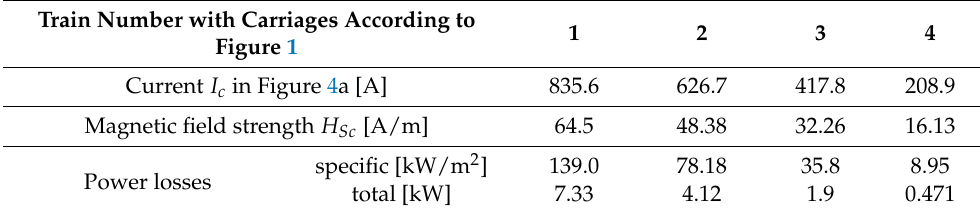
Figure 4. Calculation schematic for the superimposition and mirror image methods of the magnetic field on the roof of the electric locomotive created by currents in the equivalent contact wire and the current collector (pantograph): ( a ) side cross-section; ( b ) front cross-section. Table 5. Calculation of power losses in the steel sheets of the locomotives’ roofs and bottoms. Train Number with Carriages According